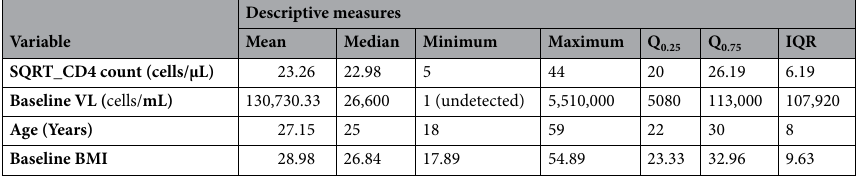
Table 1. Descriptive statistics for non-categorical variables.